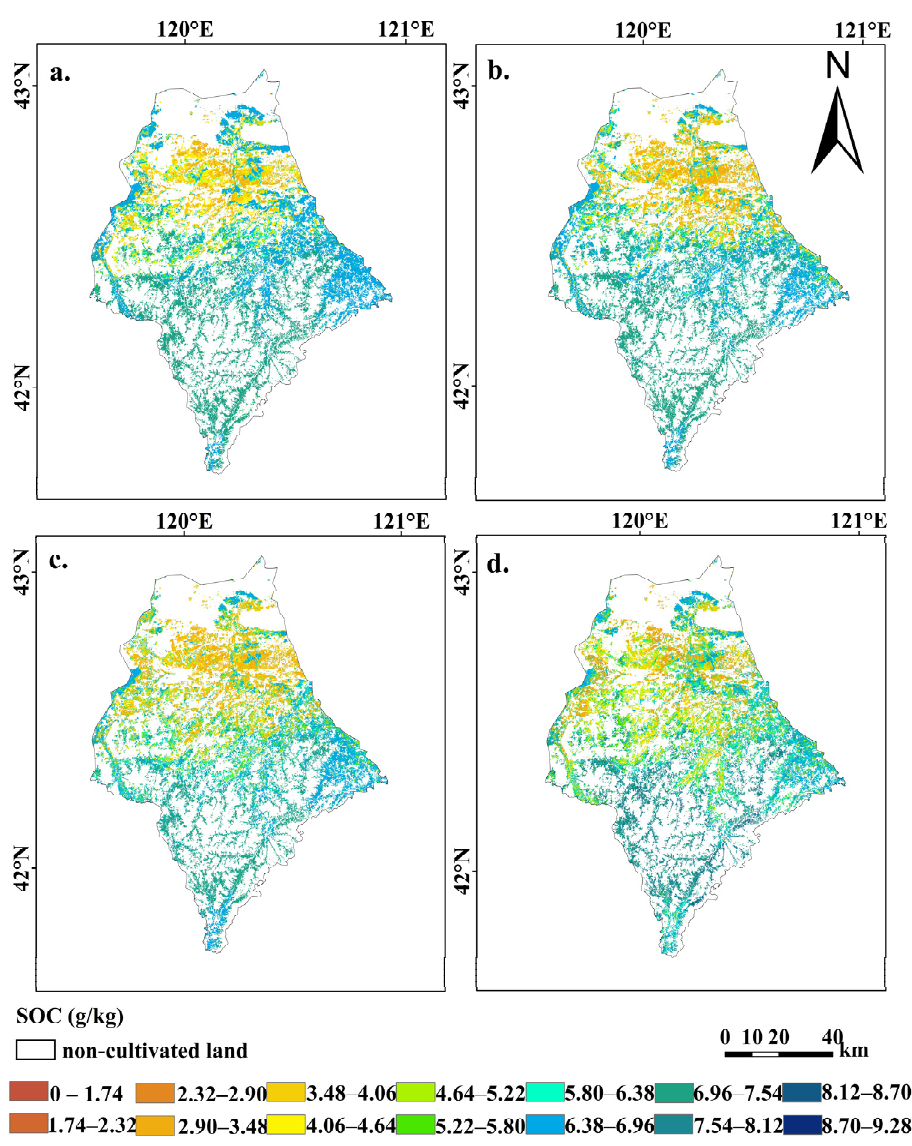
Figure 4. Spatial distributions of the soil organic carbon (SOC) in 1989 ( a ), 2001 ( b ), 2009 ( c ) and 2018 ( d ) with a resolution of 30 m.